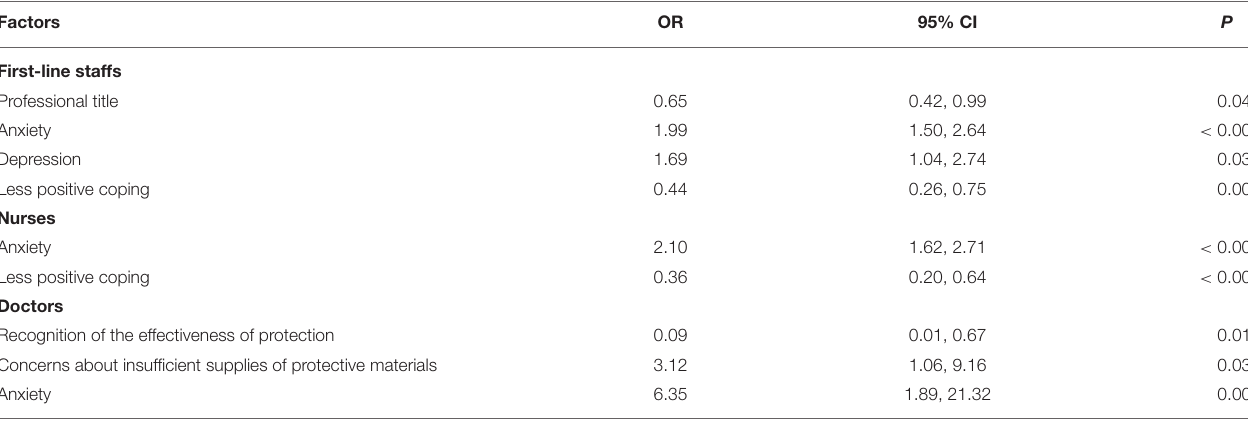
TABLE 6 | Logistic regression on factors for sleep disturbance among battlefront staffs. Factors